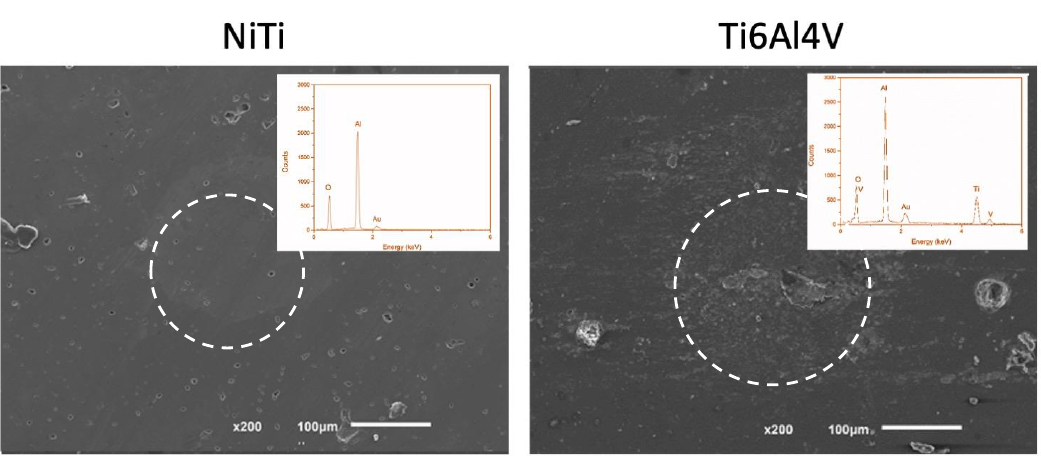
Figure 8. SEM images of the mating counter material surface (alumina ball) and EDS spectrum taken on the marked zones: LB-PBF NiTi alloy on top and LB-PBF Ti-6Al-4V alloy on bottom [4].